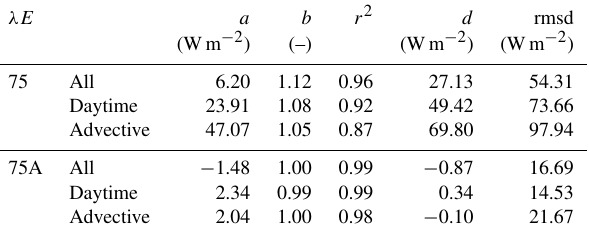
Table 2. Performance characteristics of LI-7500A and LI-7500 with reference to the LI-7500RS for corrected latent heat fluxes ( λE ). These include regression offset value ( a ), regression slope ( b ), co- efficient of determination ( r 2 ), mean absolute bias ( d ), and compa- rability